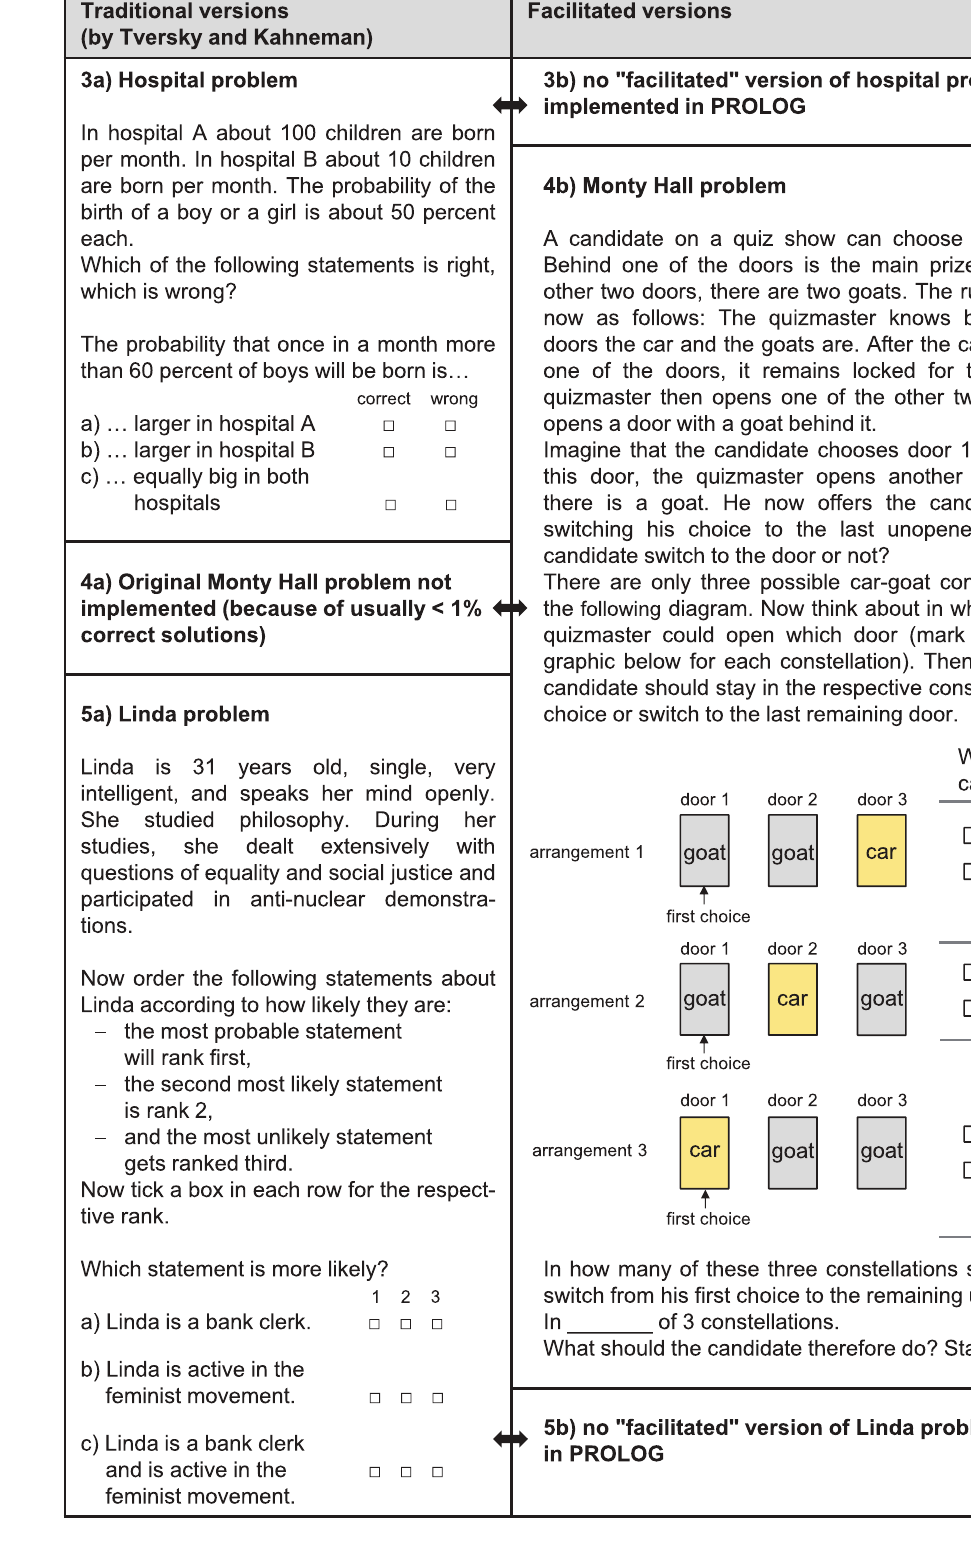
FIGURE 1 | All items of cogIll